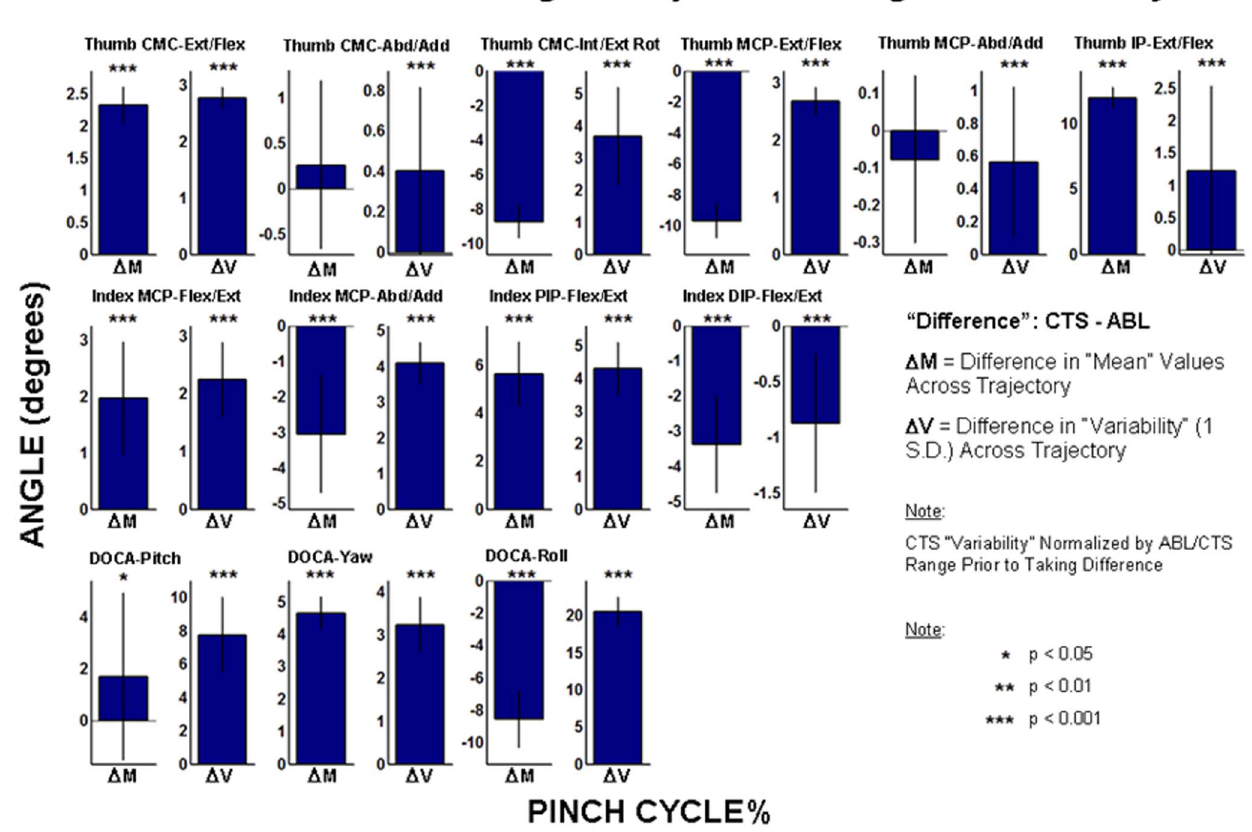
Figure 5. Differences ( D ) in mean-value (M) and variability (V, ± 1s.d. about mean trajectory) of mean angular trajectories of digits between ABL and CTS groups.